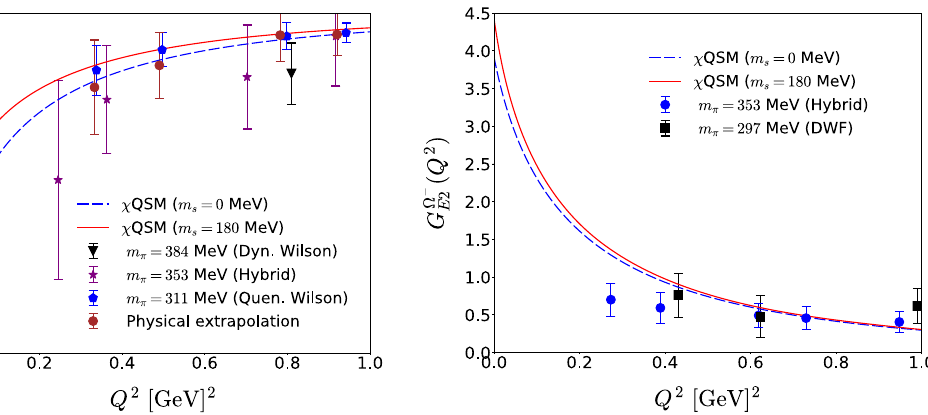
Fig. 11 Effects of the explicit flavor SU(3) symmetry breaking on the electric quadrupole form factors of the (cid:2) + isobar and (cid:5) − in the left and right panels, respectively. The dashed curves depict the E2 form fac- tors without the effects of the explicit flavor SU(3) symmetry breaking,